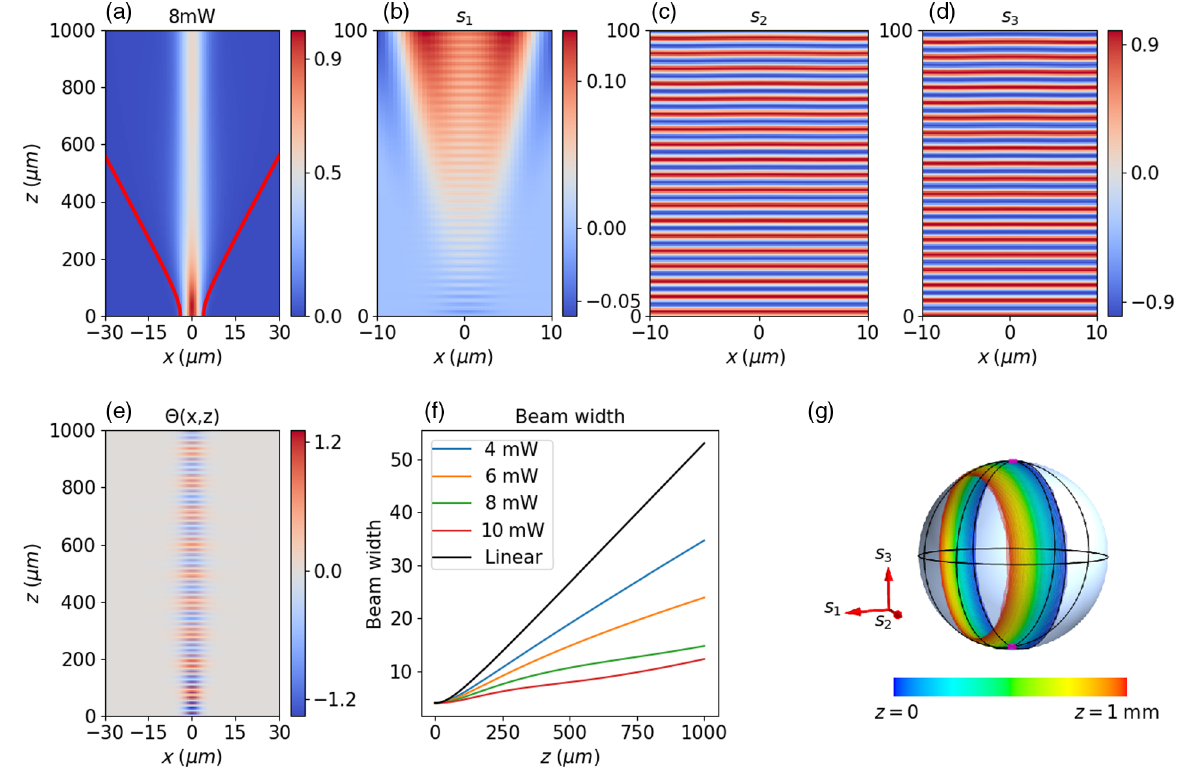
4 μ m. (a) Evolution of a high-power ( P ¼ 8 mW) Gaussian FIG. 2. Numerical simulations for a Gaussian beam of input width w in ¼ beam propagating through a homeotropically aligned NLC cell. The red solid lines show the linear diffraction. (b) – (d) Polarization evolution of the beam, both in the transverse and longitudinal direction, shown in terms of the normalized Stokes parameters s 1 , s 2 , and s 3 . (e) Corresponding light-induced periodic rotation of the optical axis resulting in the confinement of the beam. (f) Evolution of the width of the beam with decreasing power (bottom to top curve). The topmost curve shows the linear diffraction. (g) Mapping on the Poincar´e sphere of the dynamics along z of the polarization state measured at the center of the Gaussian beam. The blue (red) color corresponds to small (large) propagation distance z (check the color bar below the Poincar´e sphere for the chromatic gauge). Here, the input polarization is RCP, λ ¼ 1064 nm, n ¼ 1 . 7 , and n ⊥ ¼ 1 . 5 k